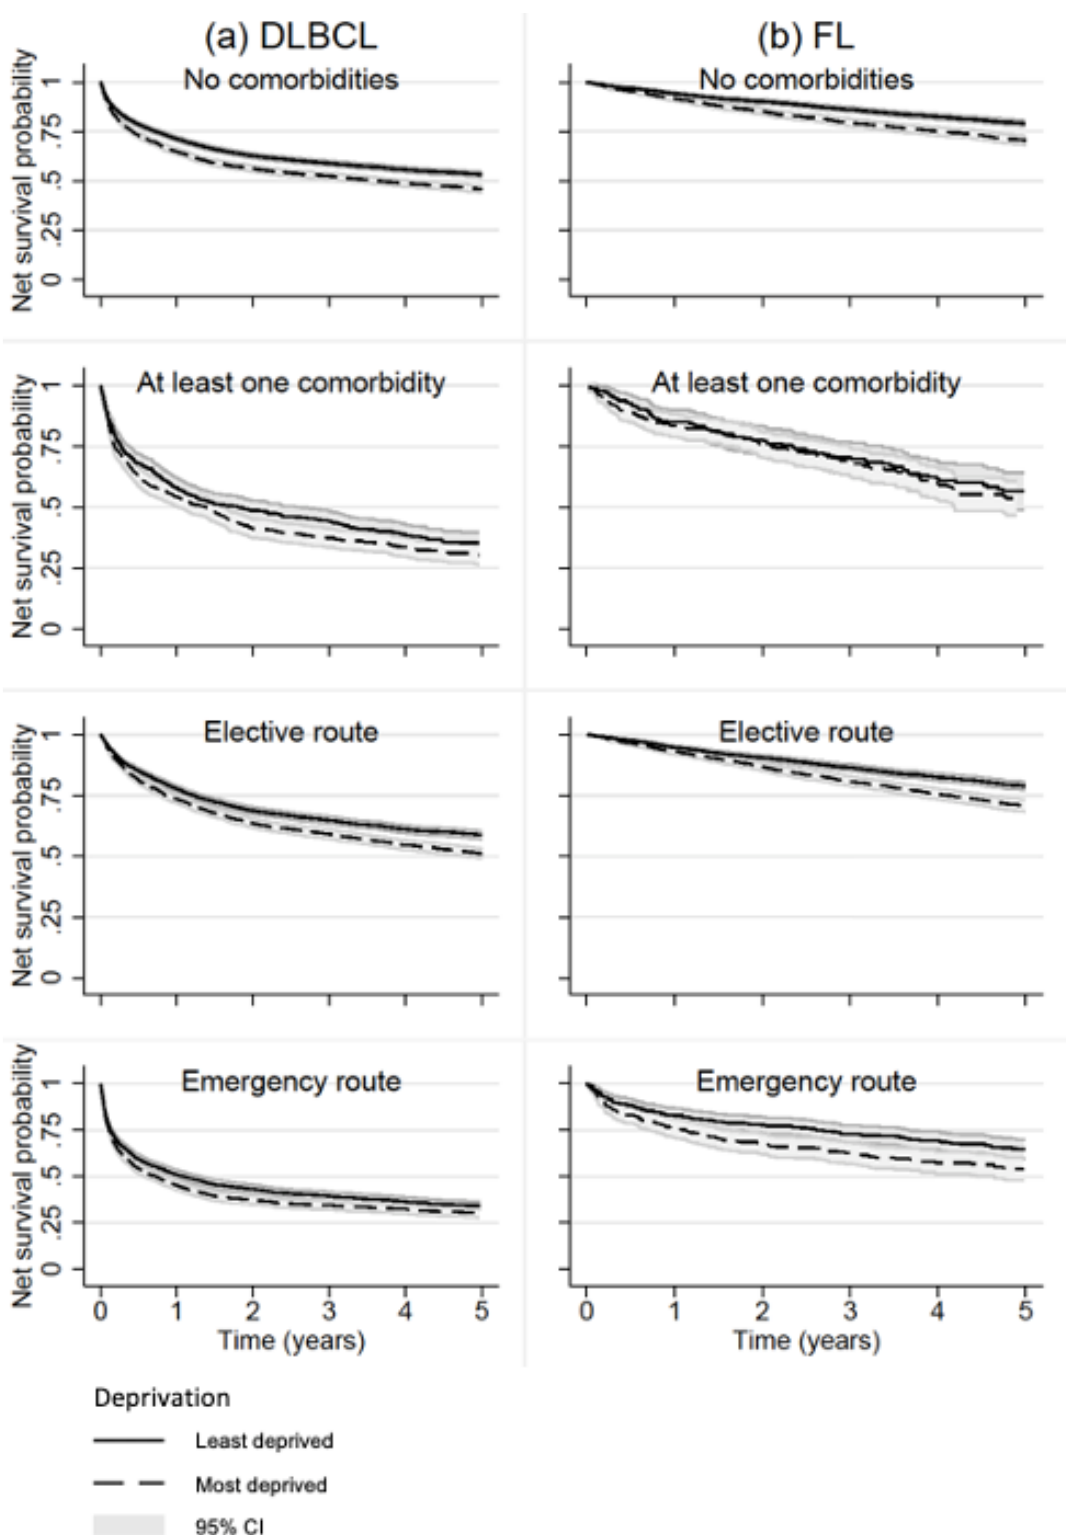
Figure 3. Net survival probabilities by comorbidity status and diagnostic route, stratified by depri- vation level, amongst patients diagnosed with DLBCL ( n = 27,379) or FL ( n = 14,043) in England between 2005 and 2013.